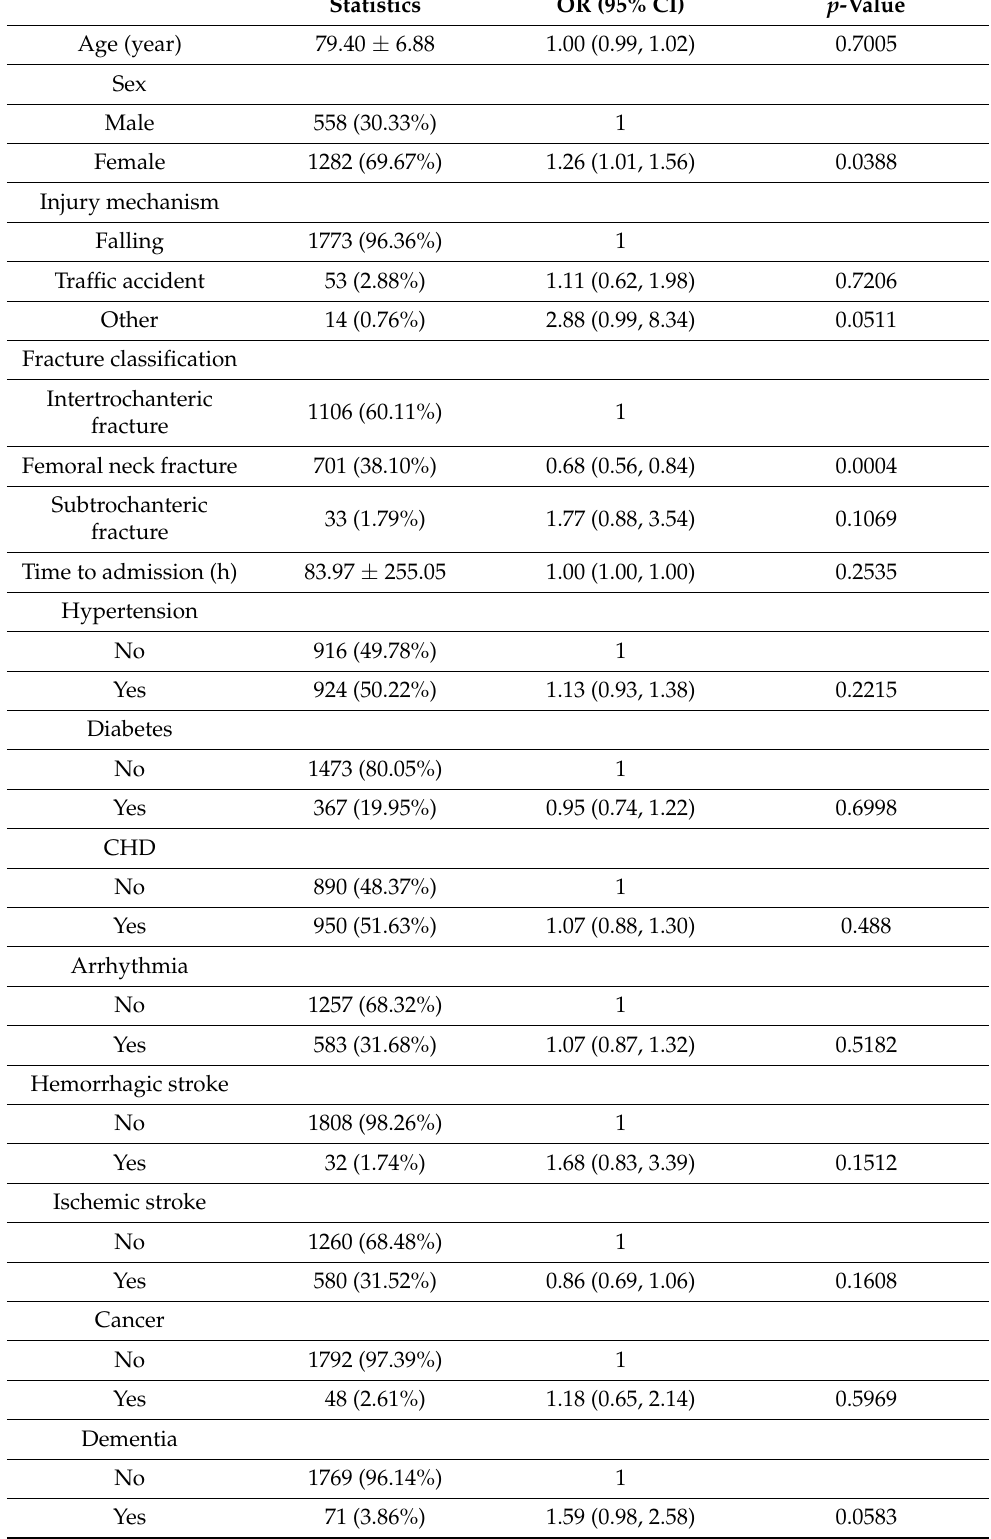
Table 2. Effects of factors on preoperative DVT measured by univariate analysis (N =